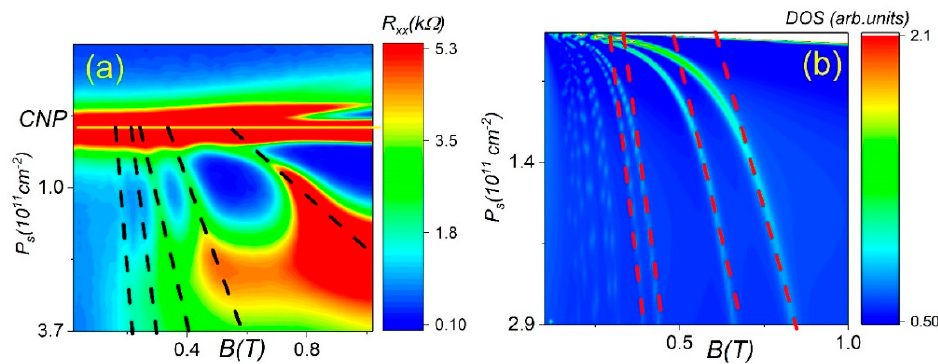
Figure 4. (Color online) ( a ) Color map of R xx ( N s , B ) versus N s and B at T = 4.2 K for a macroscopic device. Black dashes represent the slope of the LL for Dirac-like holes. ( b ) Theoretical calculations of the density of states as a function of the hole density and magnetic field. Red dashes represent the slope of the LL for Dirac-like holes.